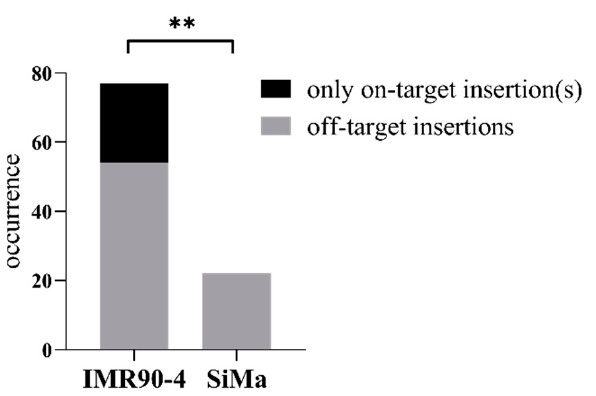
Figure 7. Targeted insertion success rate. Absolute occurrence of only on-target donor DNA insertions into the AAVS1 safe-harbor locus vs. occurrence of off-target donor DNA insertions in IMR90-4 and SiMa clones. Frequency analysis measured by X 2 , ** = p >